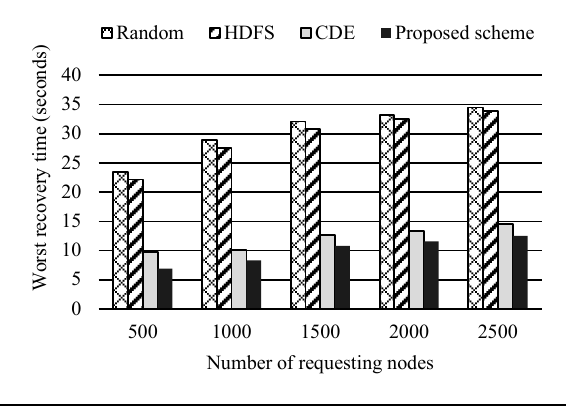
Fig. 12. The comparison of worst recovery